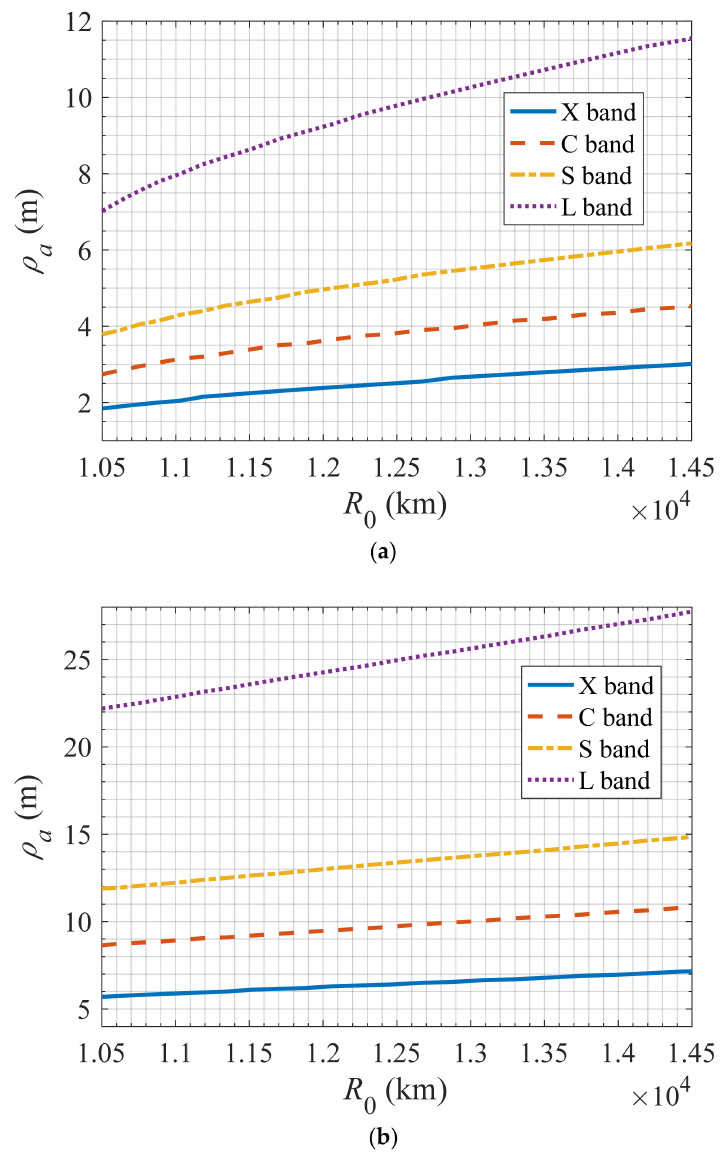
Figure 10. Lower Bounds of azimuth resolution. ( a ) Targets with constant speeds and ( b ) accelerating